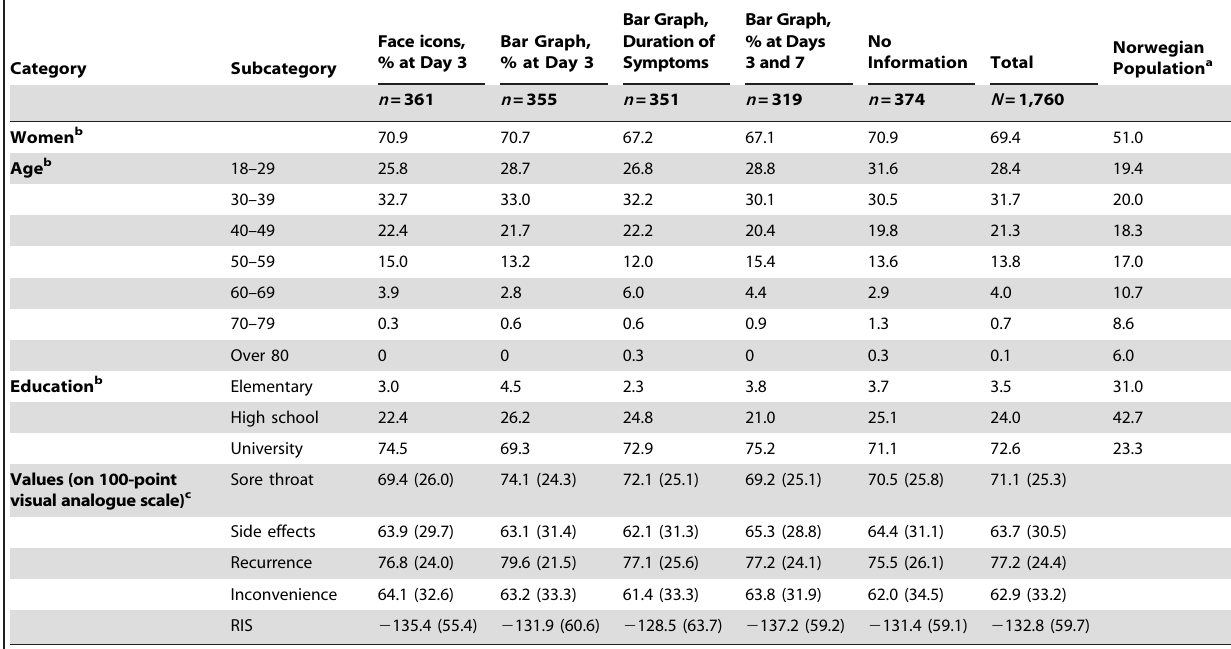
Table 1. Participant characteristics.